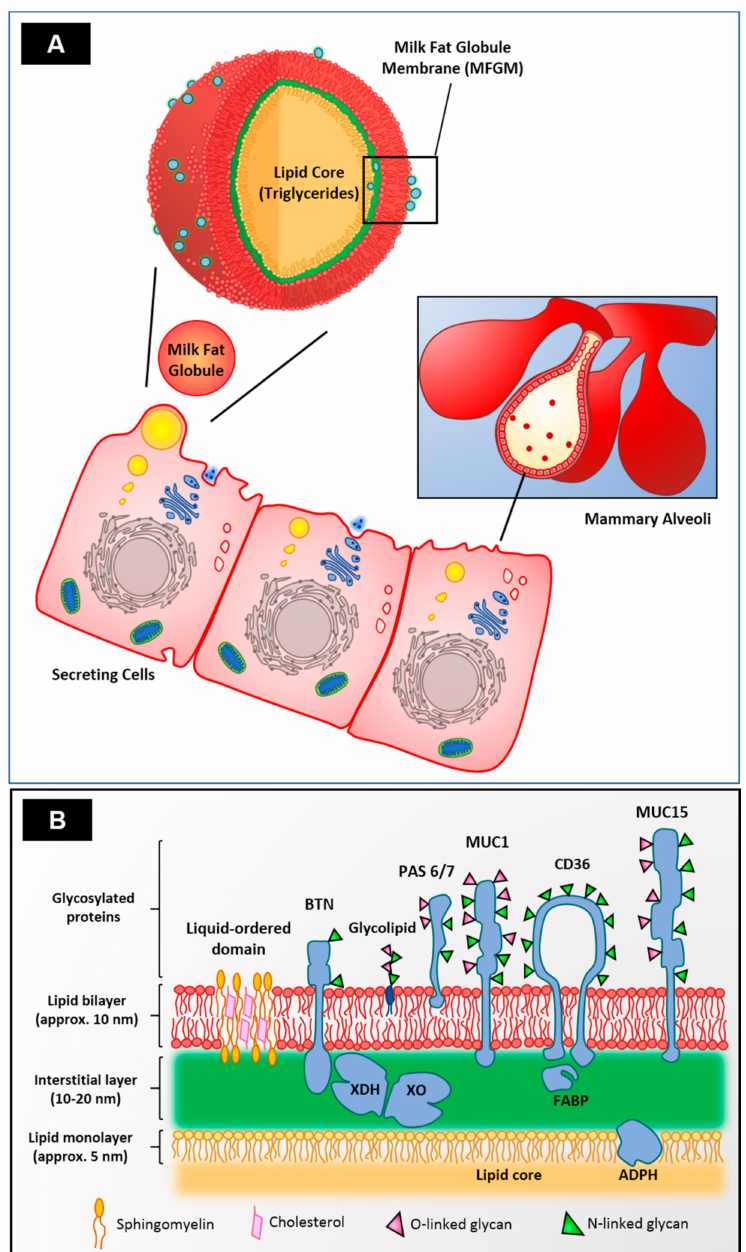
Figure 1. Schematic diagram of ( A ) the biosynthesis of fat globules during lactation and ( B ) the structure of the milk fat globule membrane (MFGM) where the different layers and their general compositions are depicted. BTN, Butyrophilin; PAS 6/7, Lactadherin; MUC-1, Mucin 1; CD36, Cluster of differentiation 36; MUC-15, Mucin 15; XDH/XO, Xanthine dehydrogenase/oxidase; FABP, fatty acid binding protein family; and ADPH, Adipophilin. Adapted with permission from Ortega-Anaya et al. (2020). Copyright 2020 Elsevier Ltd.